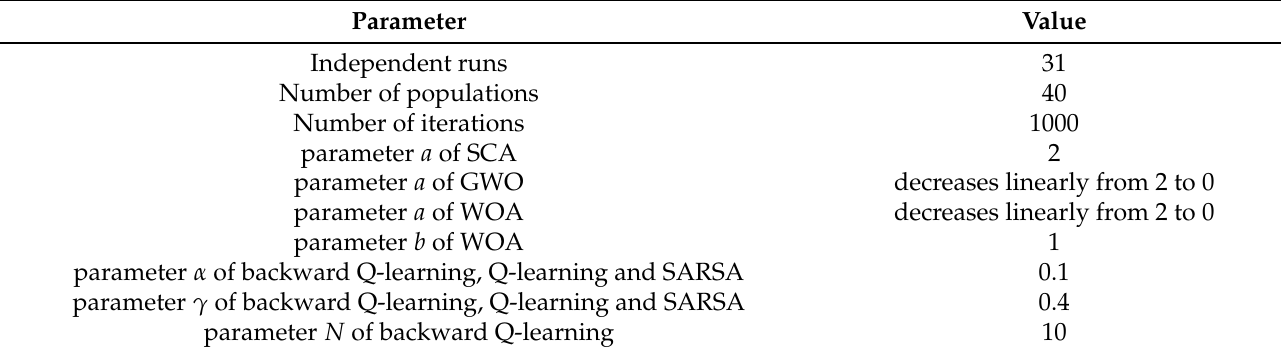
Table 2. Parameters’